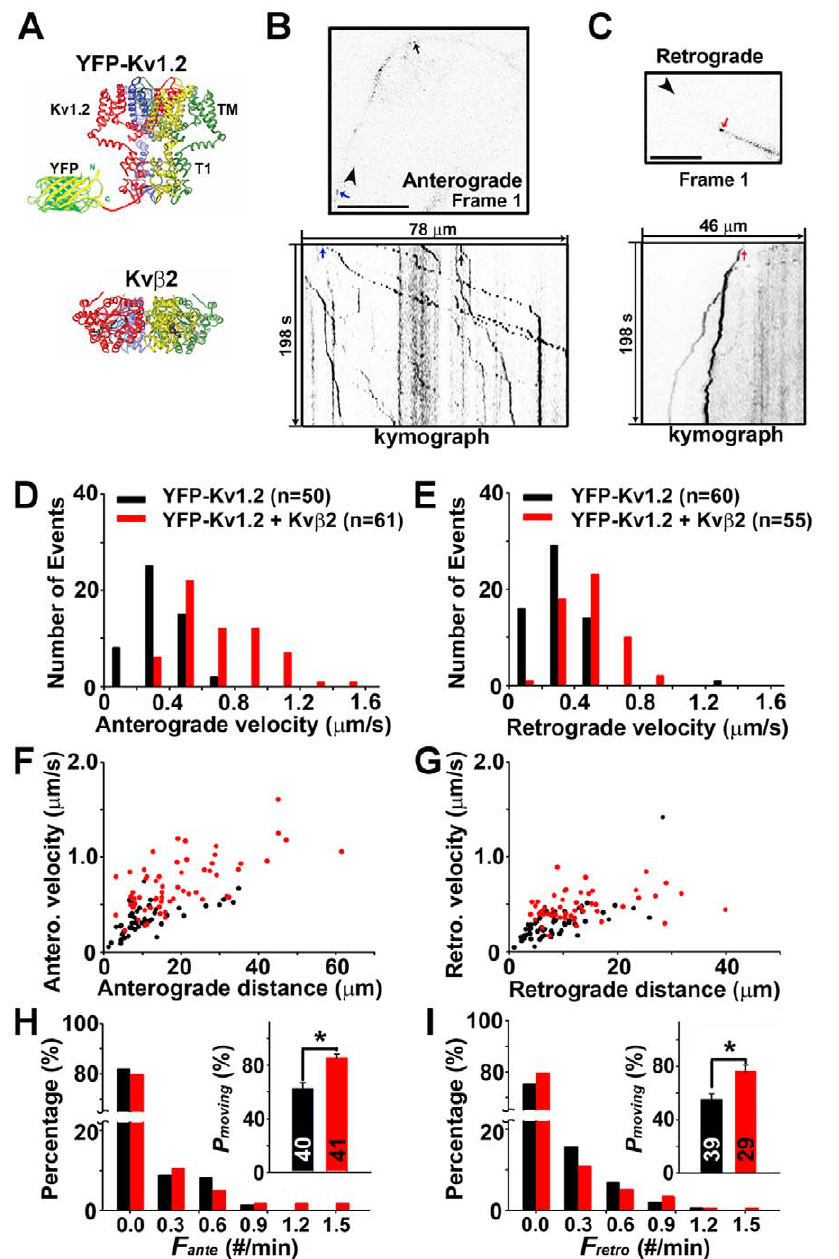
Figure 1. Kv b 2 enhances both anterograde and retrograde transport of YFP-Kv1.2 puncta along hippocampal axons. (A) Structural diagrams of YFP-Kv1.2 and Kv b 2. This Kv1.2 channel tetramer includes intracellular N-terminal T1 domains (T1) and membrane-spanning segments (TM), but not C-terminal domains. For clarification, only one YFP molecule is shown to be fused to the N-terminus of the red subunit. Kv b 2 also exists as tetramers. (B) The first frame (top) and kymograph (bottom) of anterograde movement of YFP-Kv1.2 puncta in the presence of co-expressed Kv b 2. (C) The first frame (top) and kymograph (bottom) of retrograde movement of YFP-Kv1.2 puncta. Blue, black and red arrows, three moving puncta pointed out in both the first frame and kymograph. Black arrowheads, the direction of axonal terminals. Co-expressed Kv b 2 increased the velocity of YFP-Kv1.2 puncta in both anterograde (D) and retrograde (E) directions. Expressed Kv b 2 altered the velocity and distance relationship in both anterograde (F) and retrograde (G) directions. The frequency of transport events and the percentage of moving time of puncta are provided for anterograde (H) and retrograde (I) directions. The number of puncta in each condition is provided in the bar. *, p , 0.05 in t test. doi:10.1371/journal.pone.0011931.g001 their effects on YFP-Kv1.2 axonal transport were compared. In (Fig. 2H). Travel distances of YFP-Kv1.2 puncta were similar in the presence of either CFP-Kv b 2 or CFP-Kv b 2K235E (Fig. 2I). the presence of CFP-Kv b 2K235E, both the anterograde (0.34 6 0.03 m m/s) and retrograde velocity (0.32 6 0.02 m m/s) of Next, we examined how interfering Kv b 2-EB1 binding affects YFP-Kv1.2 puncta significantly decreased, compared to CFP-Kv b 2 Kv1 axonal transport. In our previous study, we identified a mutant of Kv b 2 (YFP-Kv b 2C2) whose binding to EB1 was disrupted [19]. (anterograde: 0.61 6 0.05 m m/s; retrograde: 0.46 6 0.03 m m/s)